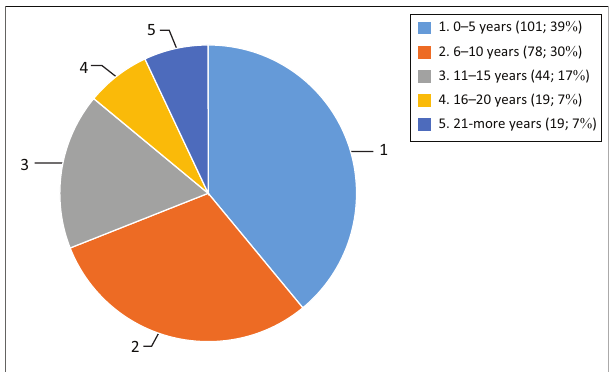
FIGURE 3: Number of years involved in budgeting and financial management policies.